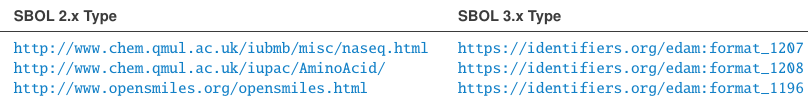
Table 18: Mapping of Sequence encoding values from SBOL2 to SBOL3